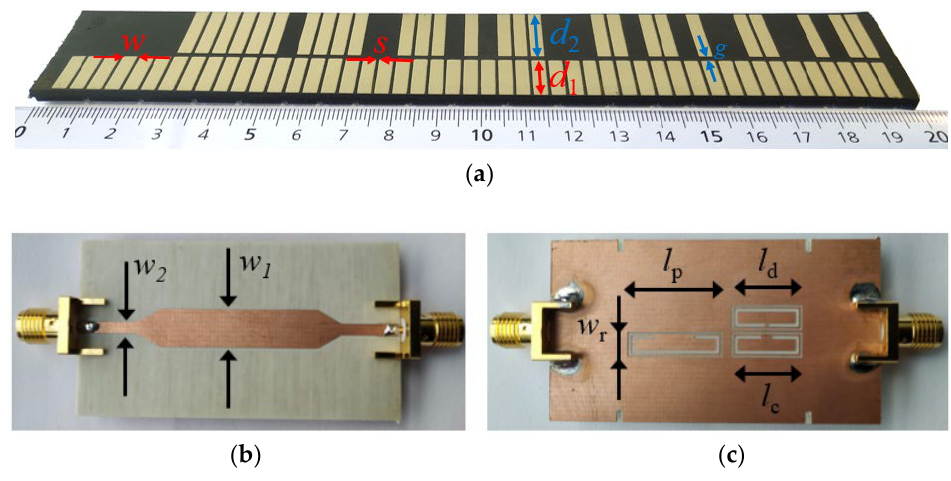
Figure 2. Photograph of the quasi-absolute electromagnetic encoder implemented on a rubber elevator belt ( a ) and photograph of the top ( b ) and bottom ( c ) views of the reader. The dimensions of the encoder are: d 1 = 11.5 mm; d 2 = 15.9 mm, w = 3 mm, s = 1 mm and g = 1.9 mm. The chain period is p = 4 mm. Note that L / p = 48; thus, N = 6. The reader (stator) was fabricated on the Rogers RO4003C substrate with thickness h = 0.81 mm, dielectric constant ε r = 3.38, and loss factor tan δ = 0.0027. The dimensions of the stator are: transmission line widths w 1 = 6.4 mm and w 2 = 1.9 mm; CSRR widths w r = 2.9 mm (for the three resonators); resonator lengths l c = l d = 10.5 mm and l p = 14.5 mm; ring splits s d = 0.4 mm, s c = 1.6 mm, and s p = 6.2 mm; CSRR slot width c = 0.5 mm. The sub-index c, d, and p in the variables corresponding to resonator’s length and ring splits are used to differentiate the CSRRs.